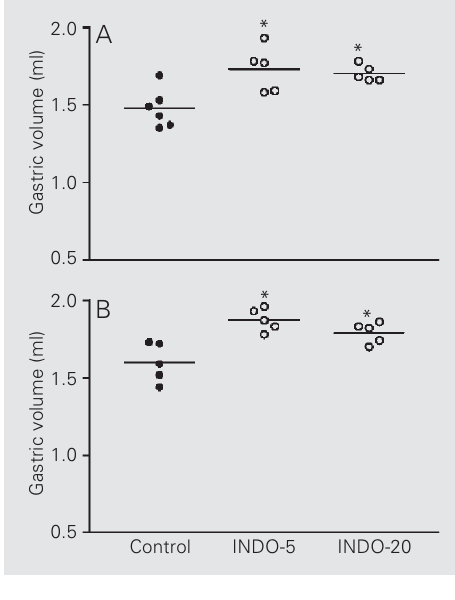
Figure 4. Gastric emptying of sa- line (panels A and C) or Susta- cal ® (panels B and D) in rats treated with 5 or 20 mg/kg in- domethacin (INDO-5 or INDO- 20) or control rats injected with Tris buffer. The studies started 1 h (panels A and B) or 3 h (pan- els C and D) after indomethacin administration. Data are indi- vidual values of the radioactivity remaining in the stomach 30 min after saline administration or 2 h after Sustacal ® administration. Meals were labeled with 99m technetium coupled to phytate as an unabsorbable car- rier. Results are reported as per- cent of the total activity in the gastrointestinal tract. Horizontal bars indicate the means. *P < 0.05 compared to control (ANOVA followed by Newman- Keuls